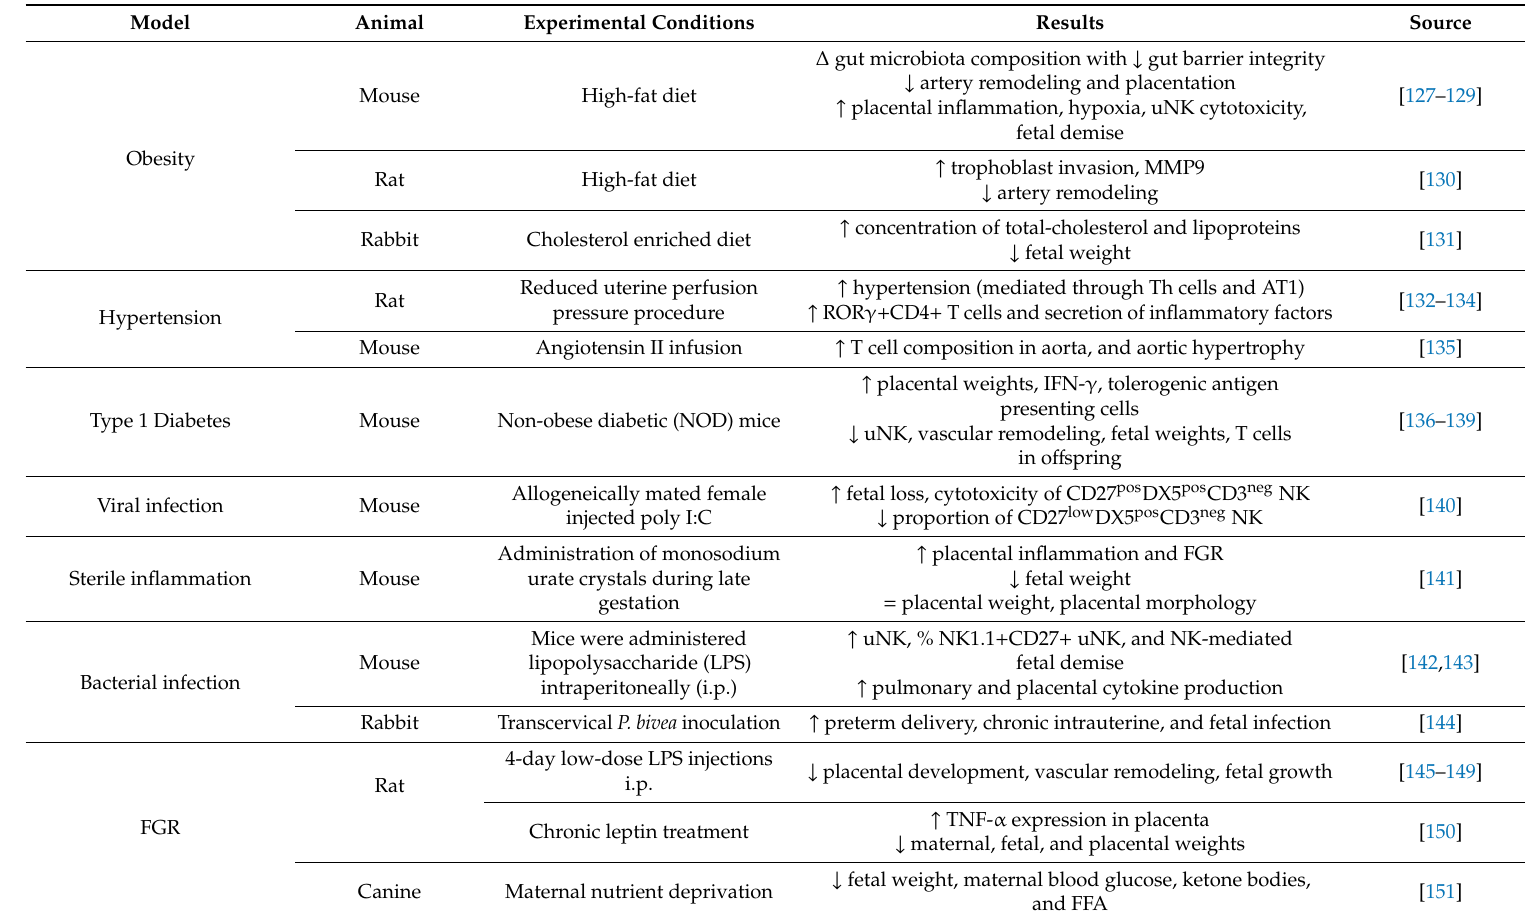
Table 1. Summarizes animal models of inflammation in